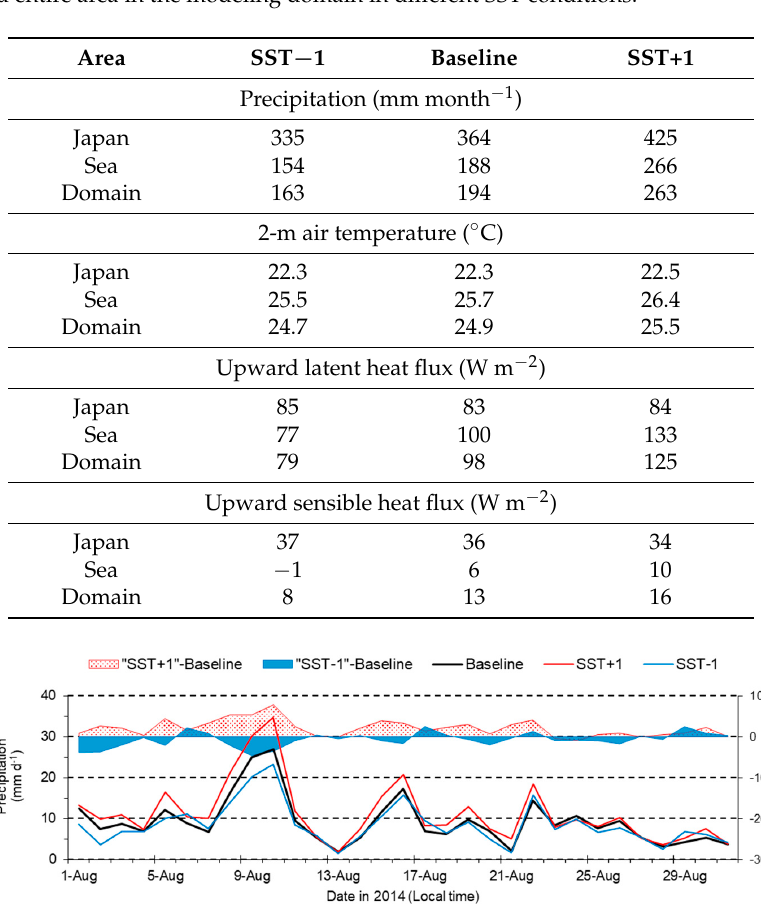
Table 4. Monthly precipitation, 2-m air temperature, and heat fluxes averaged over land area of Japan, sea area, and entire area in the modeling domain in different SST conditions.